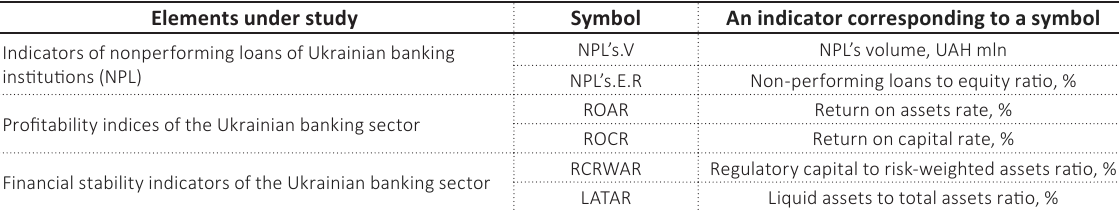
Table 1. Factors for analysis of the relationship between nonperforming loans, profitability and financial stability indicators in Ukraine’s banking sector